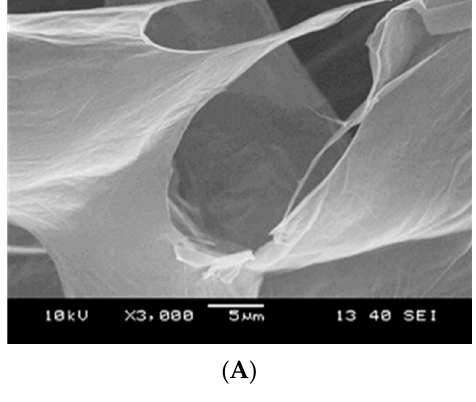
Figure 10. Scanning electron micrographs of GO samples freeze-dried from 10 mg/mL suspension before ( A ) and after shearing at 10,000 s − 1 for 5 min ( B ). The sheared sample was transferred to a plastic tube immediately after the mechanical treatment and dropped into liquid nitrogen prior to freeze-drying. The scale bar marks 5 µm. The images were taken on the 1y sample.